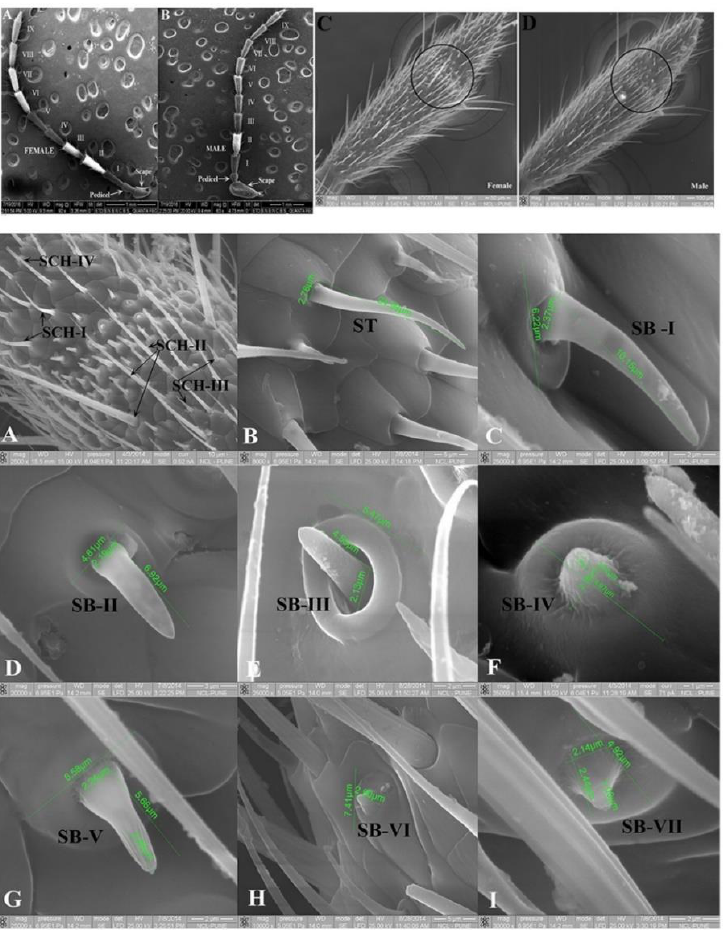
Figure 2. (Upper panel) ( A , B ) Antennae of adult Aulacophora foveicollis . ( C , D ) Location of circum- ferential band in the apical region of IXth segment in female and male A. foveicollis . (Magnification 63× – 700×). (Lower panel) (A-I) Variations and distributions of antennal chemosensilla in A. fo-